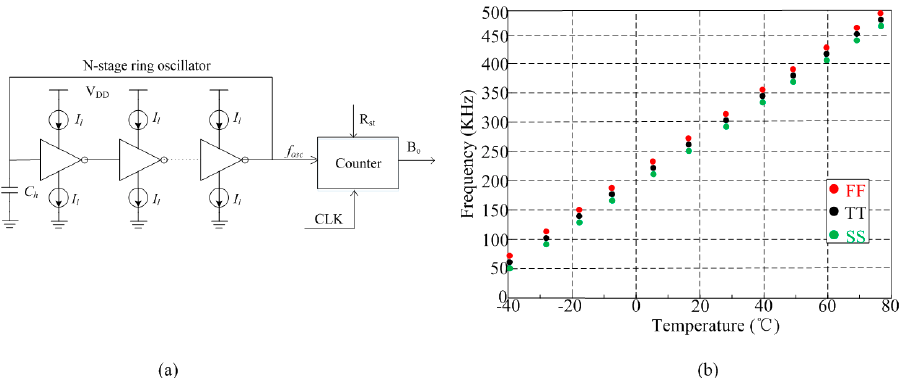
Figure 5. Proposed sensor interface: ( a ) architecture of sensor interface; ( b ) simulation results of f osc vs. temperature on different process corners.